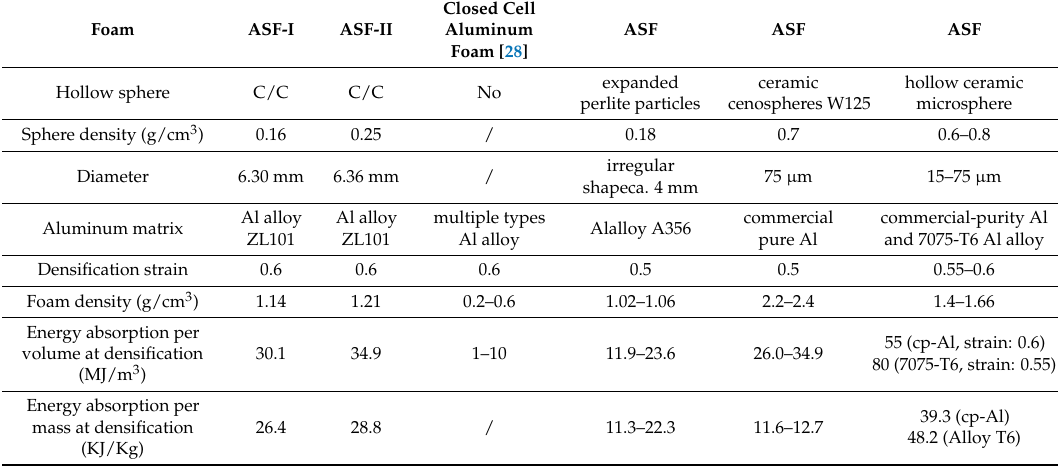
Table 4. Comparison of energy absorption capacity of our samples with other